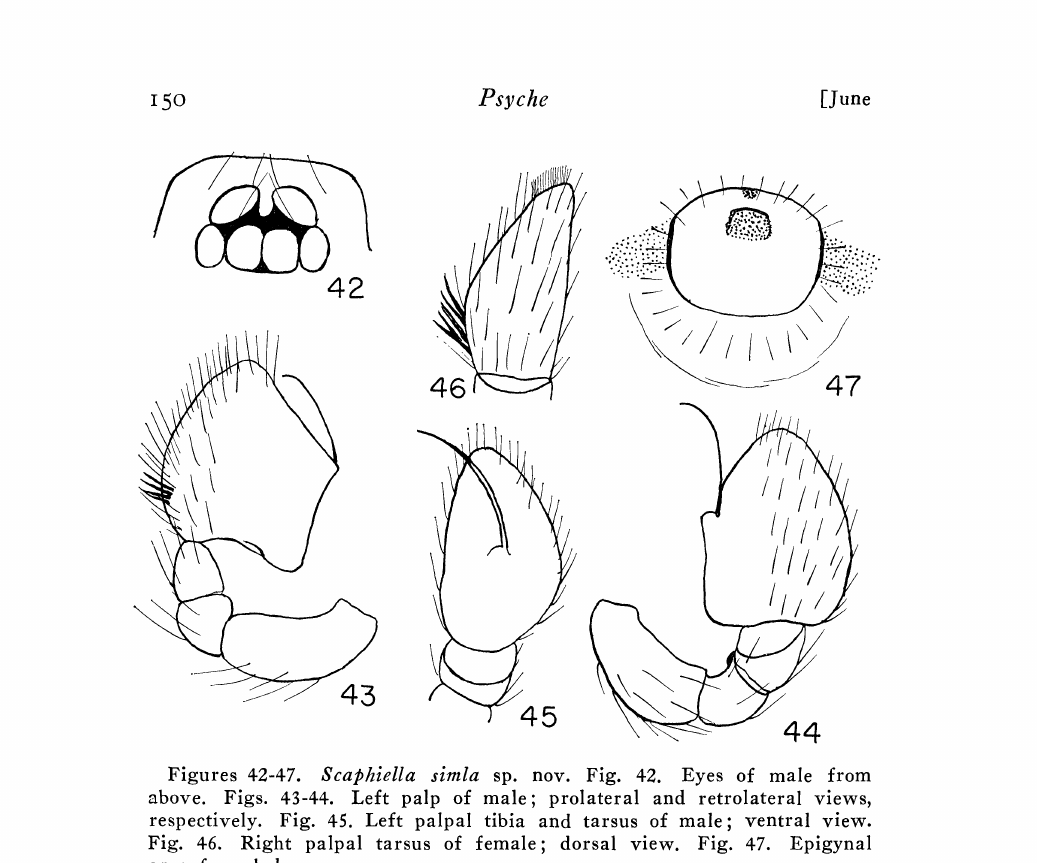
Figures 42-47. Scaphiella simla sp. nov. Fig. 42. Eyes of male from above. Figs. 43-44. Left palp of male; prolateral and retrolateral views, respectively. Fig. 45. Left palpal tibia and tarsus of male; ventral view. Fig. 46. Right palpal tarsus of female; dorsal view. Fig. 47. Epigynal area from